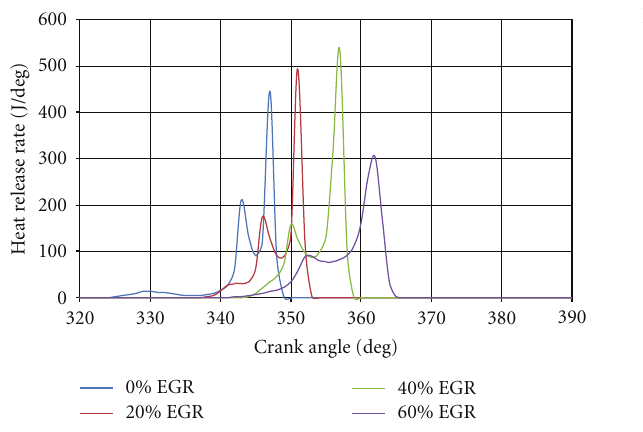
Figure 16: E ff ect of EGR on heat release rate (1400rpm; 25% load; 17.5 CR).